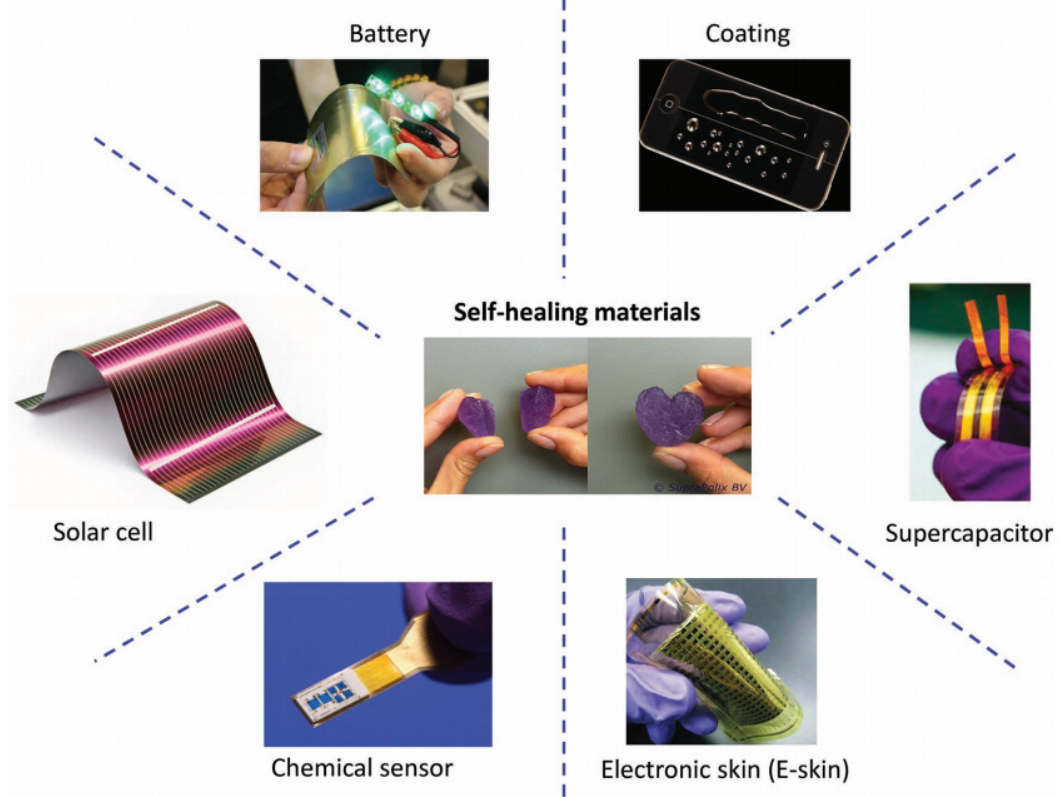
Figure 7. Present and future applications of self-healing materials for different wearable devices [97] (Copyright 2017, John Wiley &